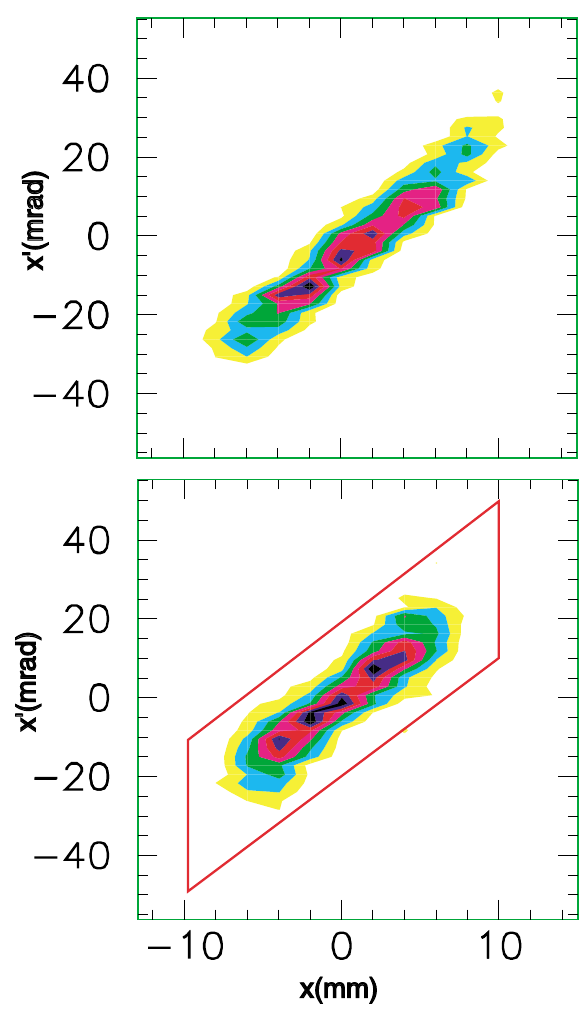
FIG. 9. (Color) Horizontal phase space measurements (top panel) at d 5 compared to the PIC simulation (bottom panel). The contour lines indicate 12.5% increments in relative inten- sity, and the color code sequence from lowest to highest intensity is yellow, . . . black. The red box indicates for the simulation the region inside of which particles were included for the PIC (88%) emittance calculations of Table II, and the interior is approximately the same as the scanned boundary in the experiment. Approximately 7% of the PIC particles lie outside of this box. An additional 5% of the initial particles are lost in the simulation upstream when the particles strike a focusing